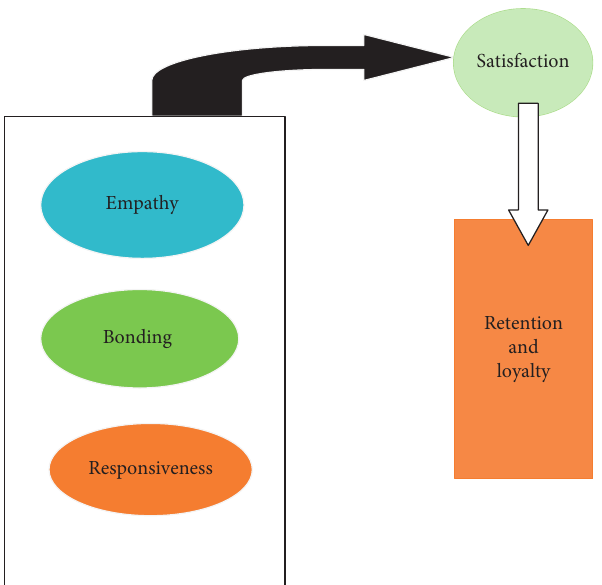
Figure 1: Conceptual frame